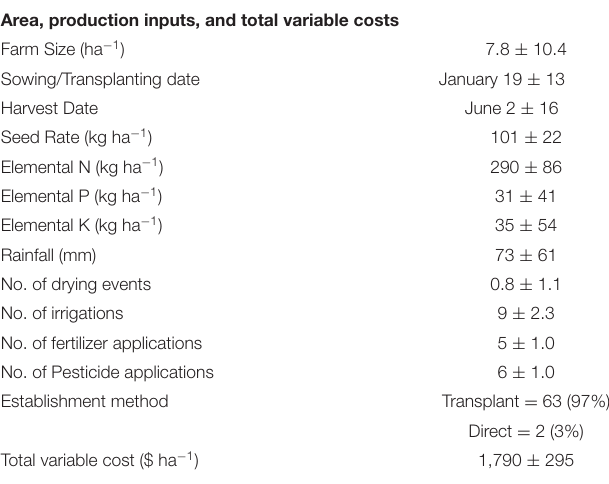
Values are mean ± standard deviation. Establishment values are the number of farmers practicing the method with the percentages